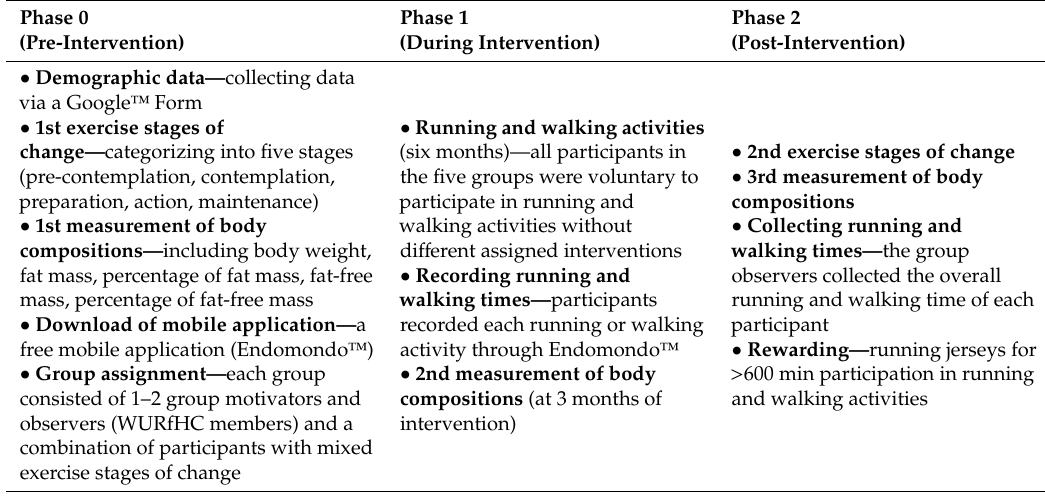
Table 1. Summary of virtual-run intervention and data-collection